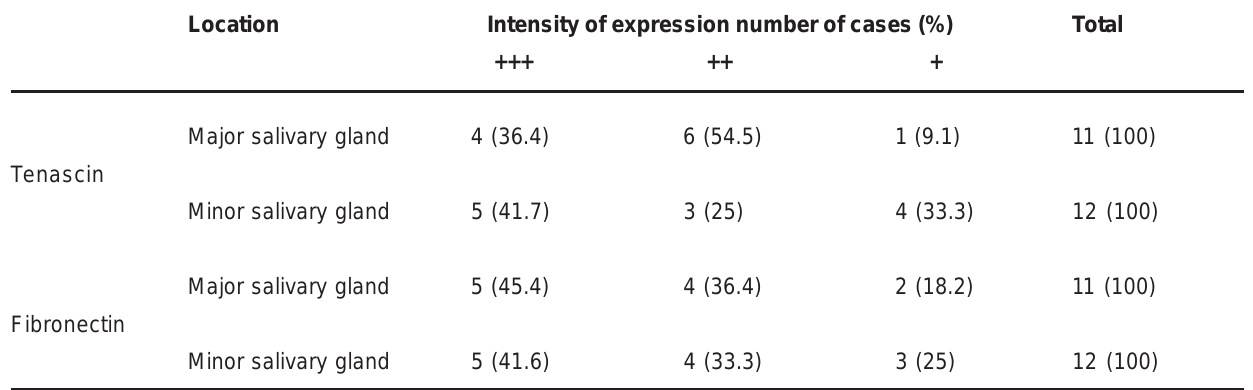
(+++) intense, (++) moderate, (+)